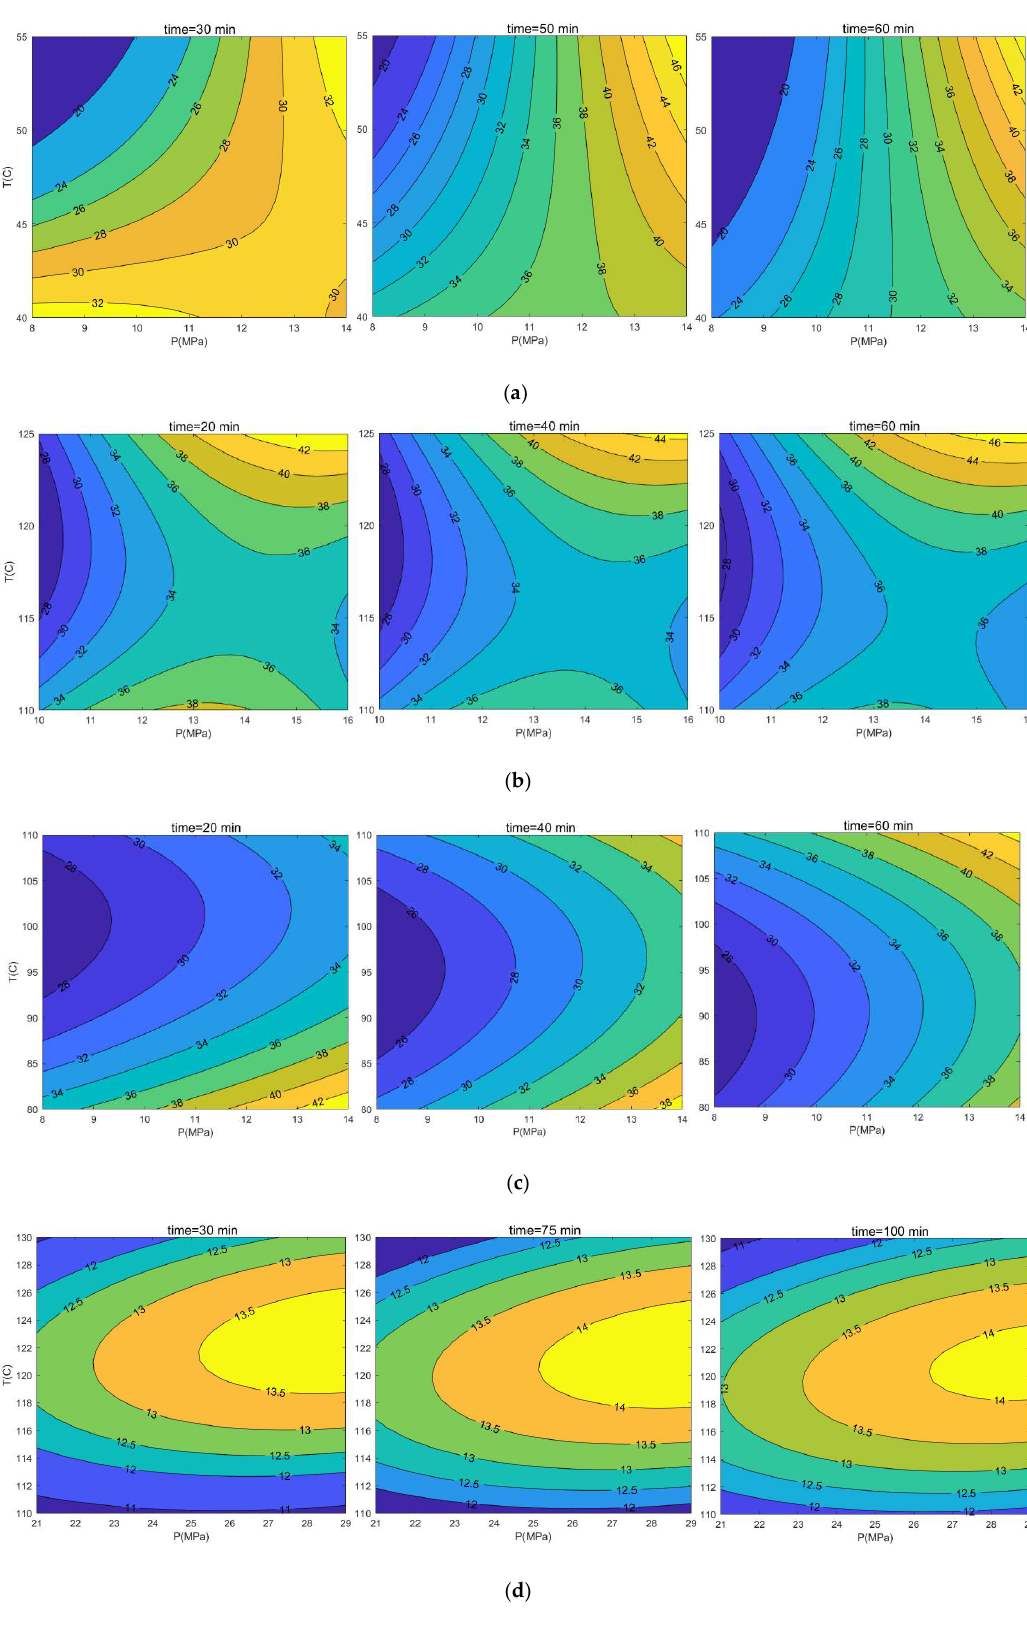
Figure 7. Contour of K/S values for acrylic ( a ), polyester ( b ), casein ( c ), and nylon ( d ) buttons as a function of dyeing time.